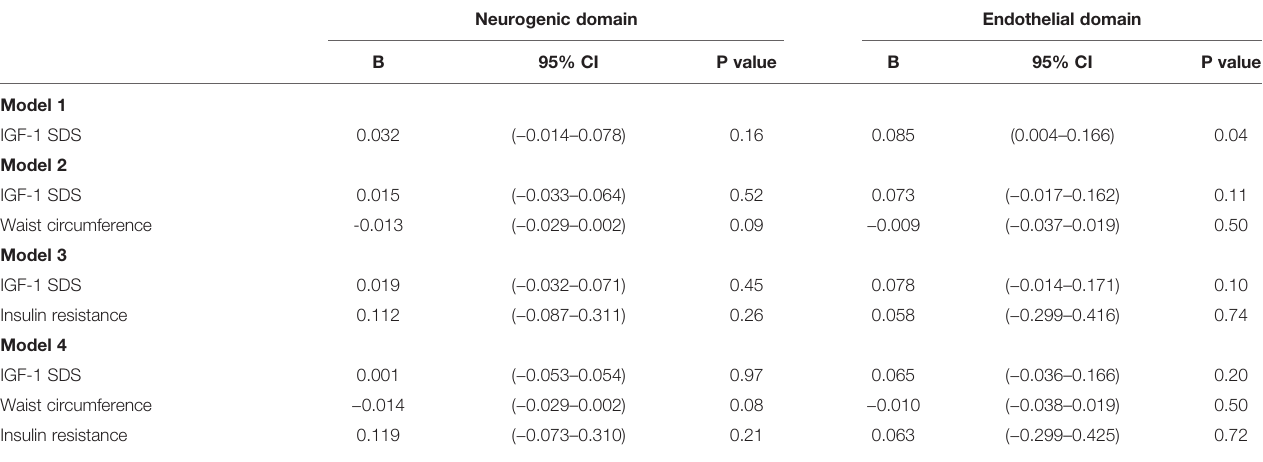
TABLE 3 | Regression analysis for change in IGF-1 standard deviation score (SDS) and the change in neurogenic and endothelial vasomotion domains and adjusted for change in waist circumference and/or insulin